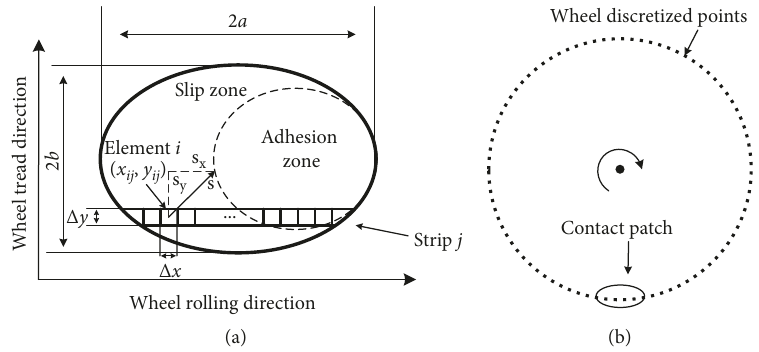
Figure 11: Wheel wear estimation: (a) discretization of the contact patch; (b) wear on wheel circumference.